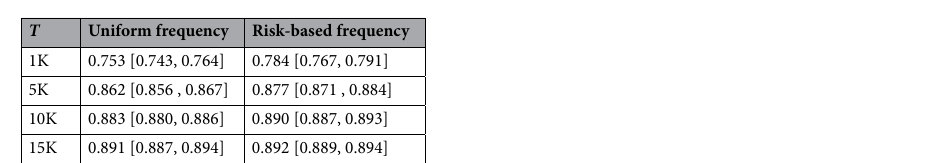
Figure 7. Effect of internal contact rates on agent-based simulations.